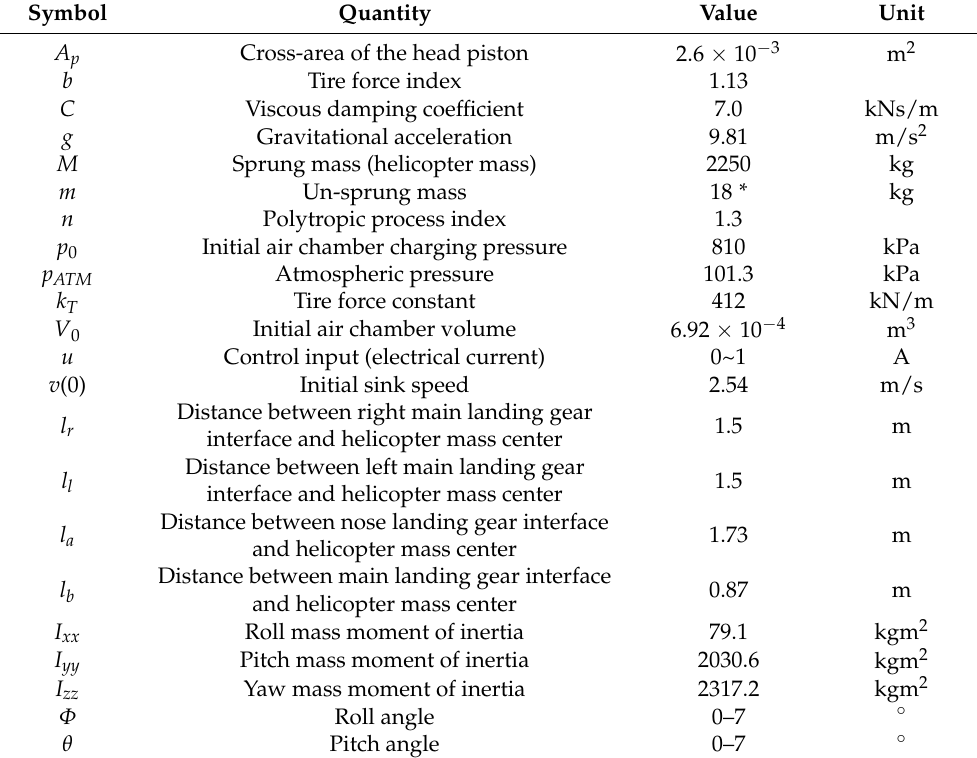
Table 1. Helicopter